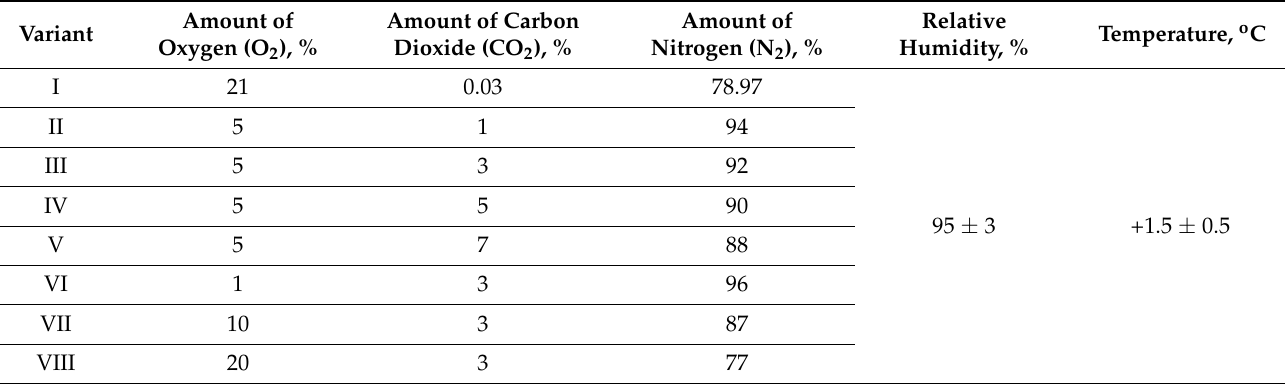
Table 1. Composition of controlled atmosphere